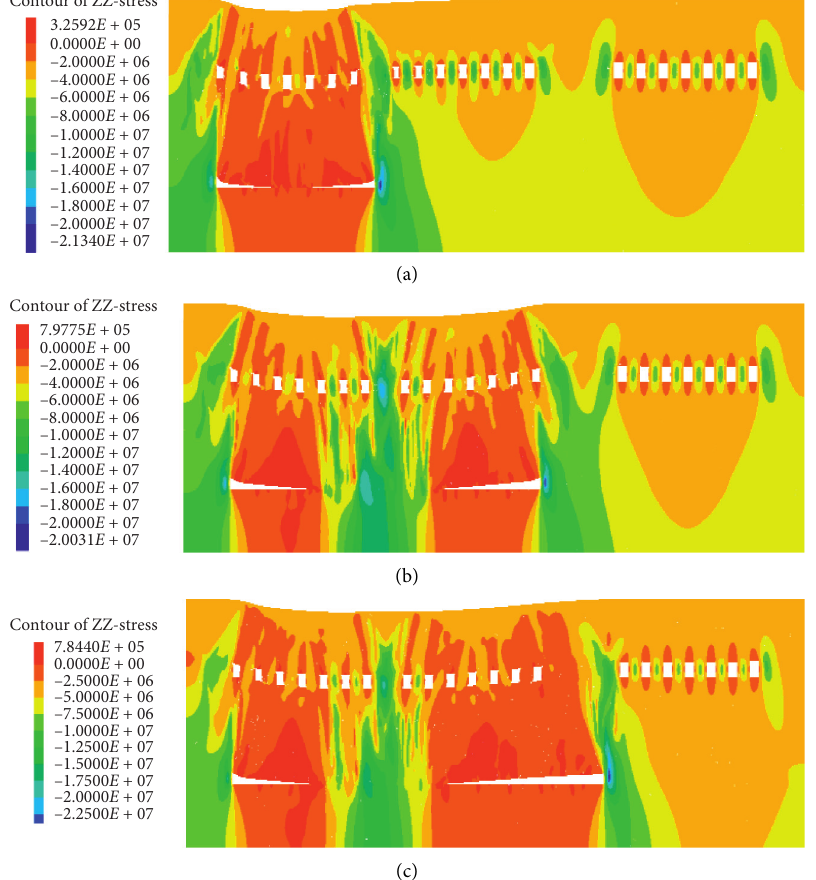
Figure 8: Stress distribution contour when the working face advancing. (a) Working face advanced to 100m. (b) Working face advanced to 200m. (c) Working face advanced to